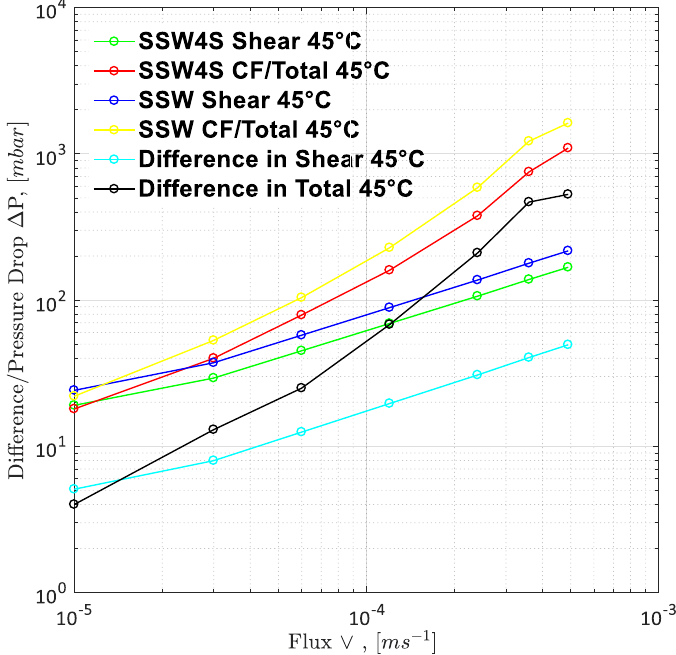
Figure 21. Pressure drop/Difference in pressure drop for two polymer solutions as function of injection rate. SSW4S represents the polymer solutions in synthetic seawater with quadruple sulfates and SSW denotes polymer solutions in synthetic seawater. CF represents core flood date.